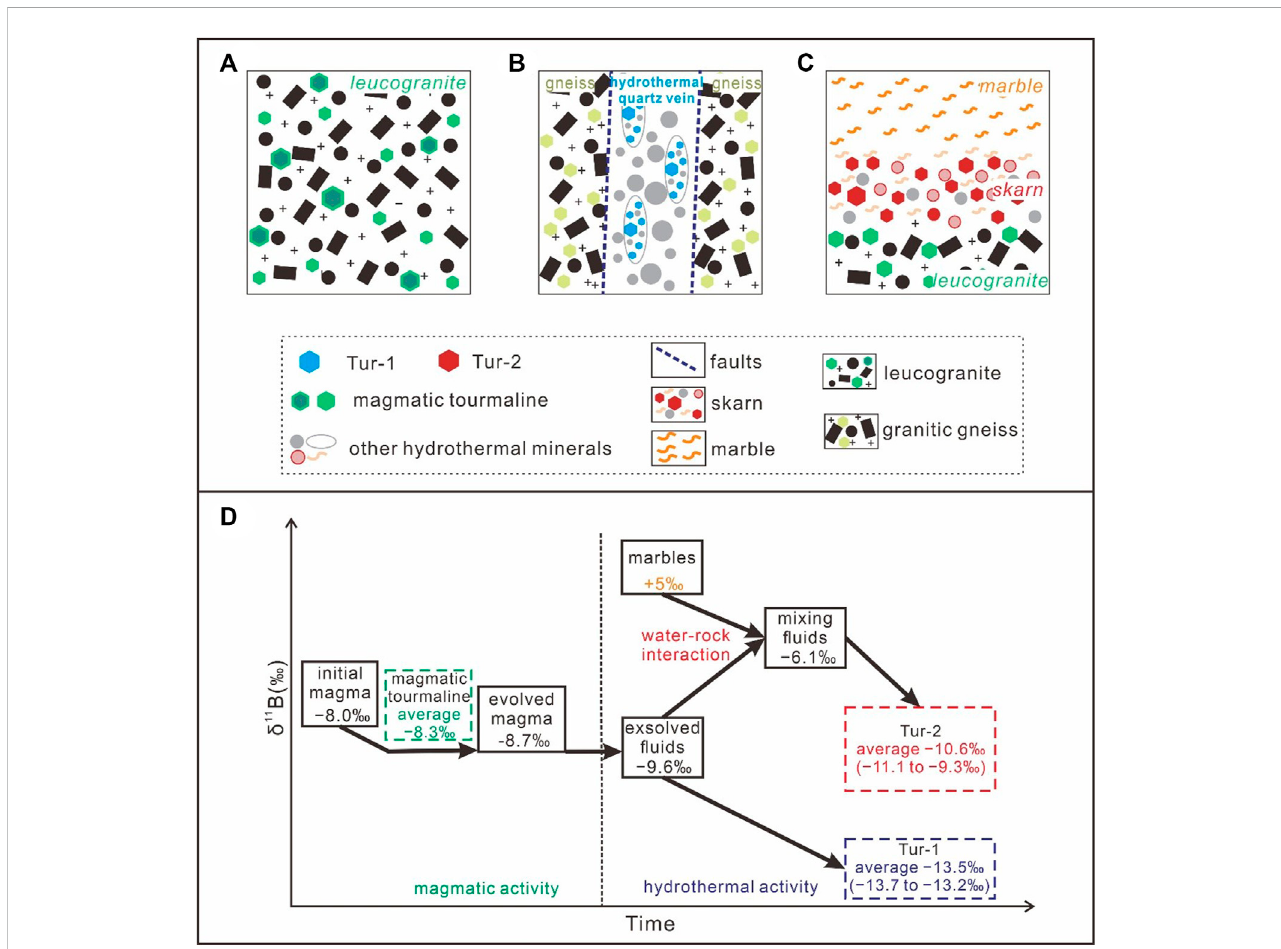
FIGURE 11 Schematic model illustrating the formation of hydrothermal tourmalines from the Cuonadong polymetallic deposit. (A) Formation model for the magmatictourmalineintheleucogranite; (B) formationmodelforTur-1inthehydrothermalquartzvein; (C) formationmodelforTur-2intheskarn; (D) boron isotope variations caused by the magmatic-hydrothermal fl uid activity and water – rock interaction between the hydrothermal fl uid and surrounding rocks. The magmatic tourmaline data from the Cuonadong leucogranite in the Xianglin area were obtained from Xie et al. (2022).